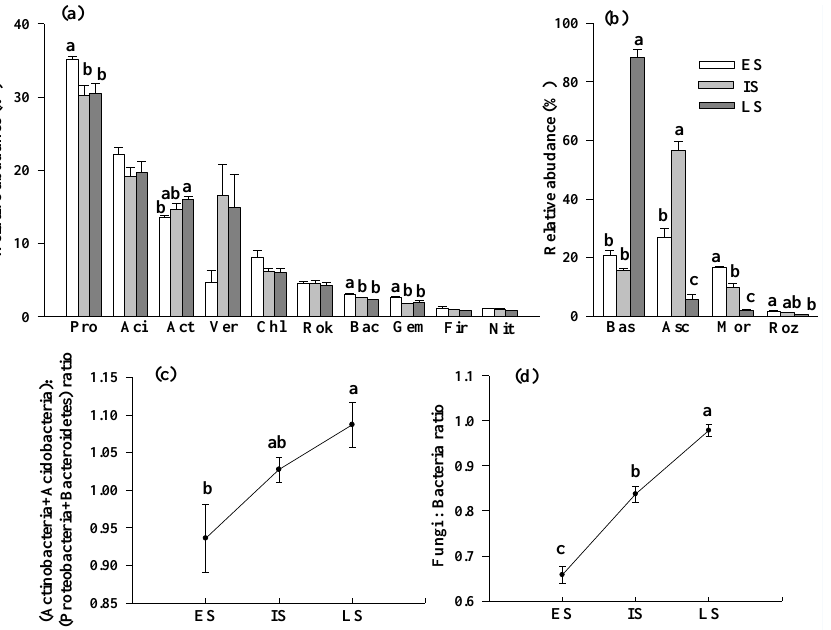
Figure 3. Relative abundance of soil bacterial ( a ), fungal ( b ) phylum-level composition and the ratio of relative abundance ( c , d ) with three successional stages of broad-leaved Korean pine forest in